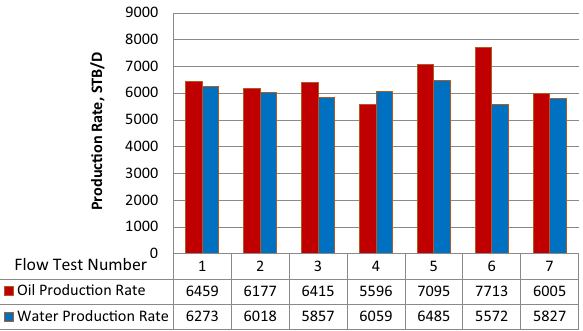
Fig. 10 Total oil and water flow rates for the seventh flow tests required for simultaneous control and monitoring steps